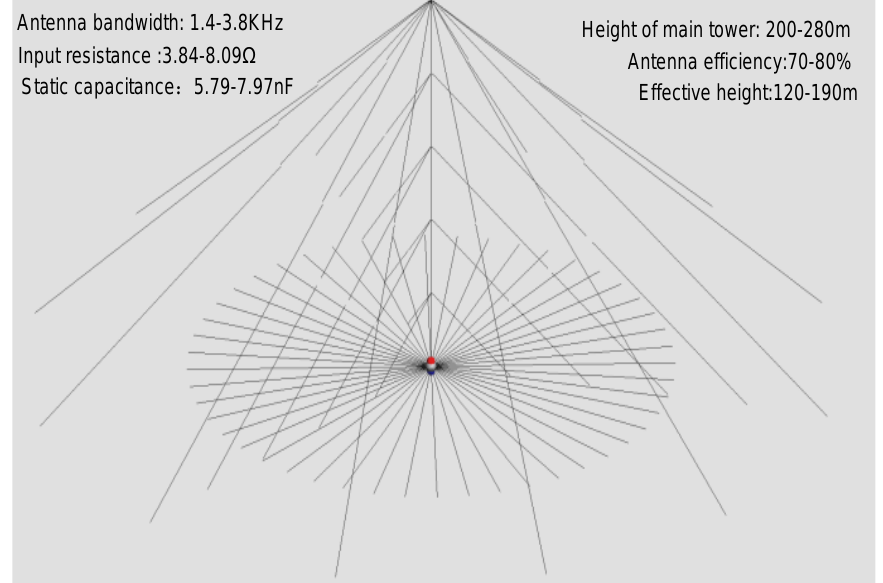
Figure 5. Schematic diagram of a single-tower umbrella antenna model. Table 1. Main Performance Parameters of the Single-Tower Antenna.